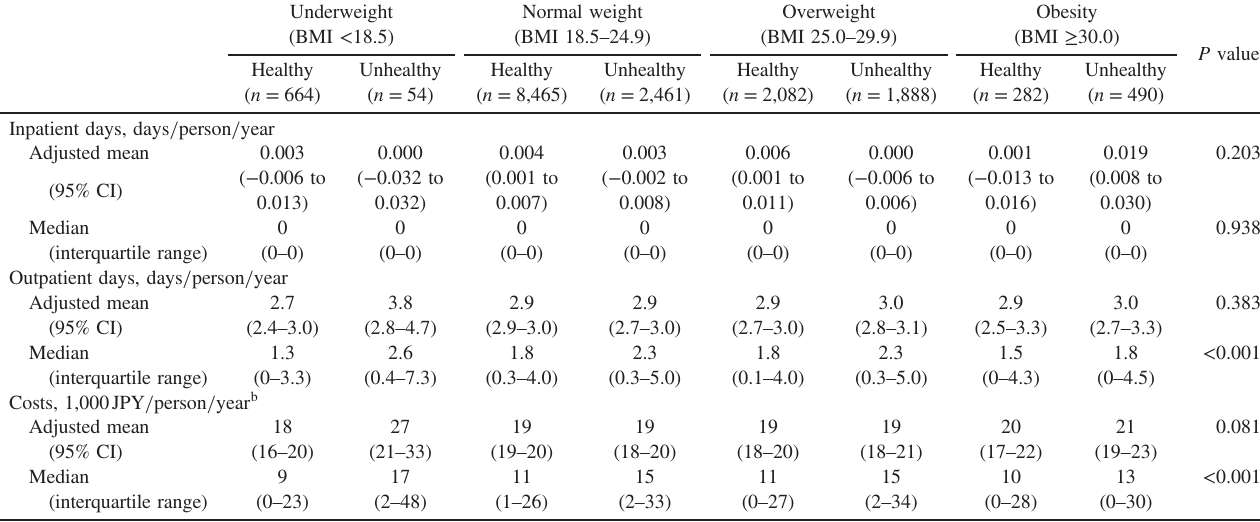
Table 3. 4-year cumulative dental care days and costs for di ff erent BMI and metabolic